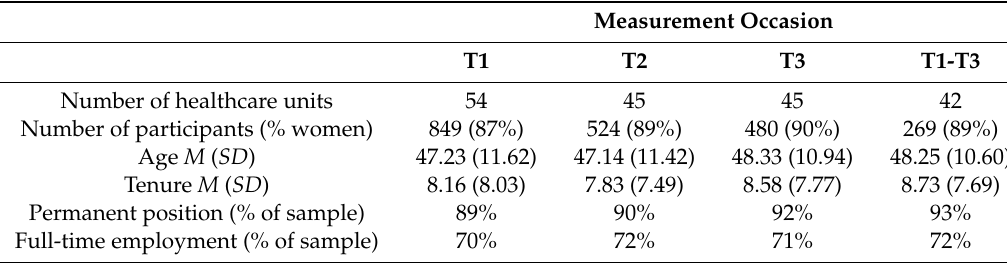
Table 1. Demographics for the employees’ sample at each measurement occasion